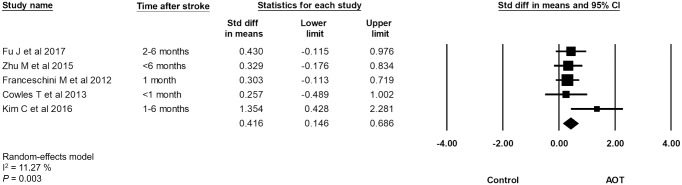
Subgroup analysis of characteristics of stroke.